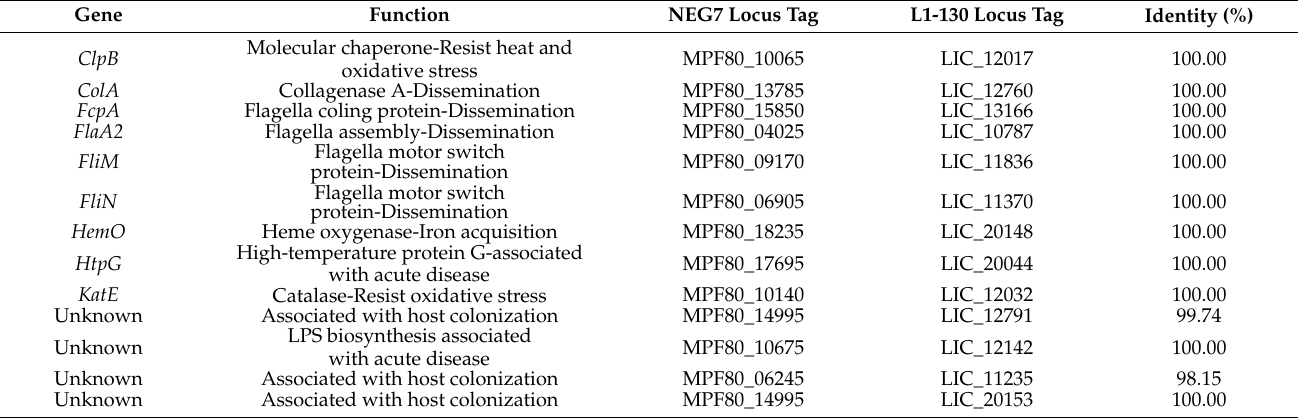
Table 2. Pathogenesis-related genes identified in the genome of L. interrogans strain NEG7 using BLAST.